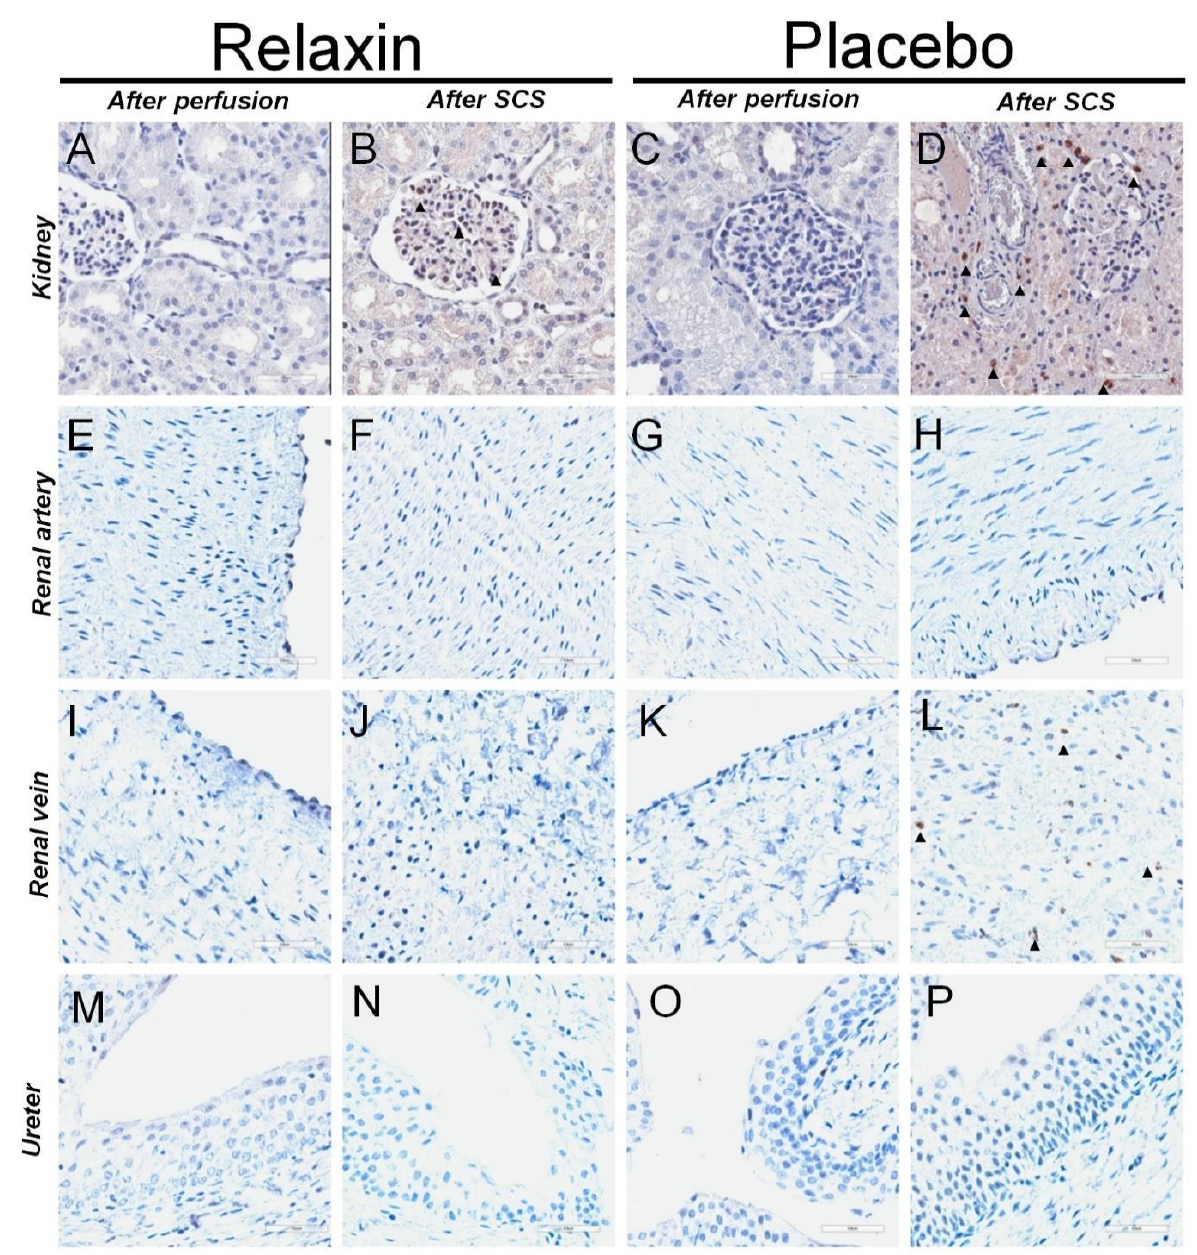
Figure 5. Representative pictures of staining against myeloperoxidase positive cells in kidney, renal artery, renal vein, and ureter tissues after perfusion and static cold storage in Relaxin or Placebo. Representative staining for kidney tissue at 100× magnification against myeloperoxidase positive cells after perfusion ( A ) and static cold storage ( B ) with Relaxin or after perfusion ( C ) and static cold storage ( D ) with Placebo. Myeloperoxidase positive cells were more common after SCS in a Placebo group. Representative staining for renal artery tissue against myeloperoxidase positive cells after perfusion ( E ) and static cold storage ( F ) with Relaxin or after perfusion ( G ) and static cold storage ( H ) with Placebo. Representative staining for renal vein tissue against myeloperoxidase positive cells after perfusion ( I ) and static cold storage ( J ) with Relaxin or after perfusion ( K ) and static cold storage ( L ) with Placebo. Representative staining for ureter tissue against myeloperoxidase positive cells after perfusion ( M ) and static cold storage ( N ) with Relaxin or after perfusion ( O ) and static cold storage ( P ) with Placebo. All scale bars represent 50 um.